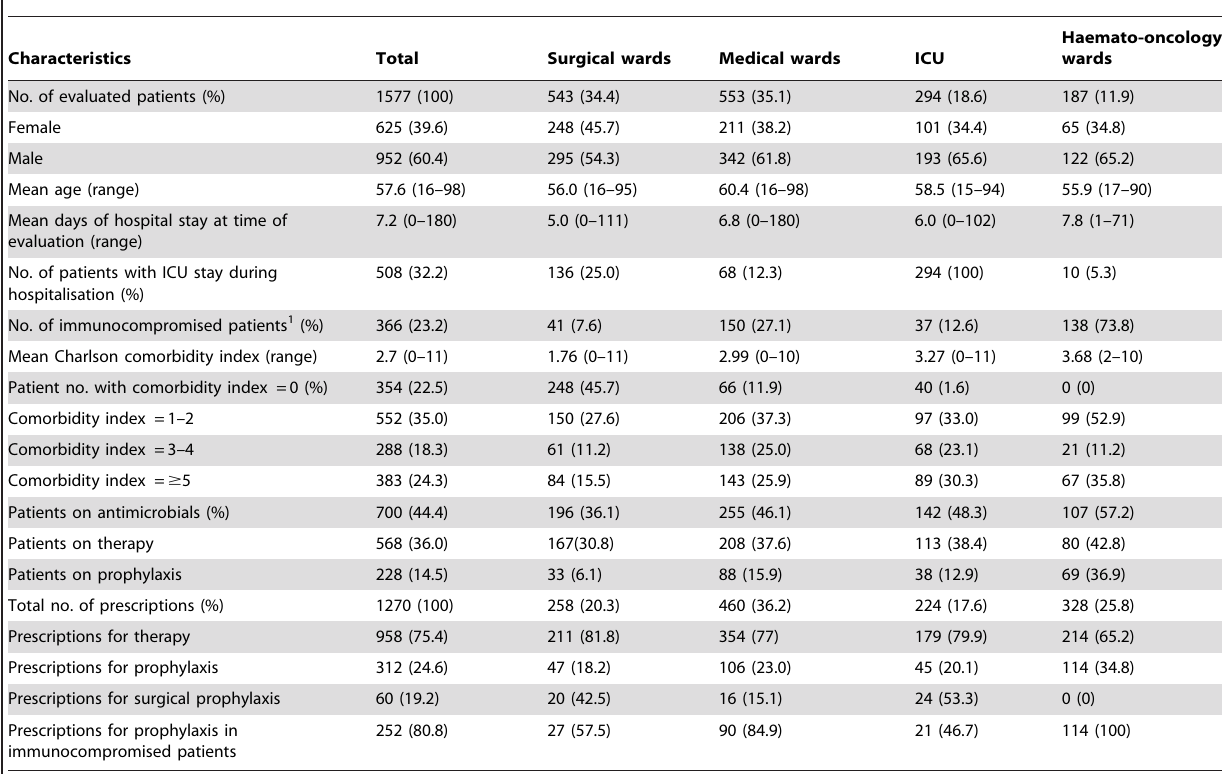
Table 1. Patient